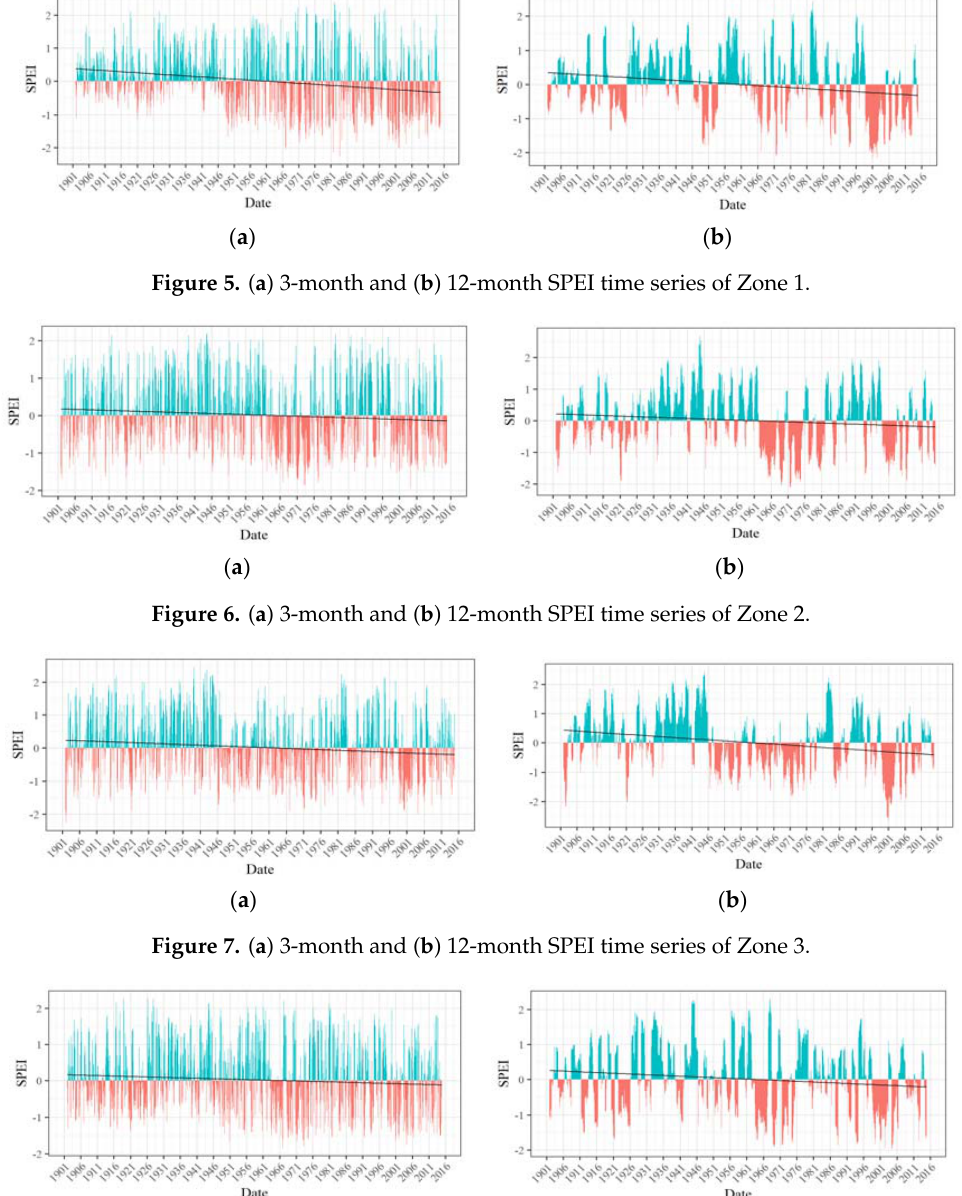
( b ) Figure 9. ( a ) 3 ‐ month and ( b ) 12 ‐ month time series of Zone 5. ( a ) ( b ) Figure 10. ( a ) 3 ‐ month and ( b ) 12 ‐ month SPEI time series of Zone 6. 3.3. Drought Characterization Run theory was applied to each zone’s SPEI time series with a threshold of − 0.5. Then, drought events identified were characterized into duration, severity, intensity, and peak. The drought durations, severities, intensities, and peaks at 3 and 12 ‐ month SPEI time scales for each zone can be visualized in Figures 11–14. The plots indicate drought termination times. A first look at Figure 11 reveals that all the zones have experienced droughts of variable durations throughout the study period. From Figure 11b, we can see that Zone 4 experienced the longest duration drought of all the zones, lasting 5 years. It started in July 1962 and ended in July 1967. This drought also affected Zone 2 for about 45 months. However, the most severe (Figure 12) drought in Balochistan’s history occurred in Zone 5 in the 2000s. Another event that stands out is the severe (Figure 12) drought occurring in all the zones roughly from 1998 to 2002 [48,49]. Both of these droughts have been reported extensively in the literature [50]. The drought occurring in 1998–2002 was experienced across vast areas of South Asia, including Western India and most of Pakistan. This particular drought is believed to have been caused by an El Nino event that started developing in 1997 in the Pacific Ocean [25]. Figures 13 and 14 show the intensities and peaks of all the drought events that occurred in each zone. Although the duration and severity graphs seem to be showing similar patterns, the same is not true for the intensities and peaks of the droughts. Therefore, the longest or most severe drought does not